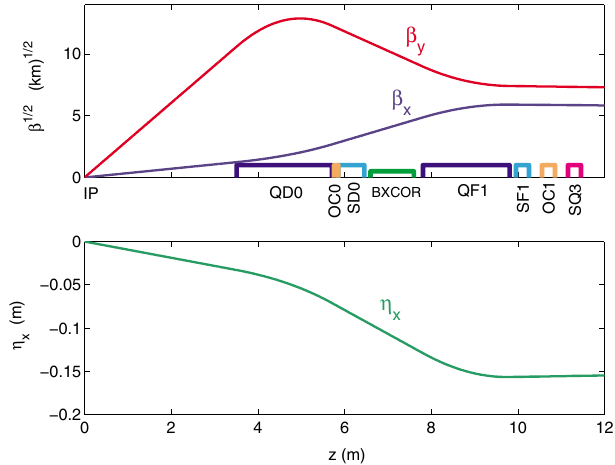
FIG. 2. (Color) Optics of the Next Linear Collider beam delivery system near the IP showing betatron functions (top) and hori- zontal dispersion (bottom). Locations of the final doublet mag- nets are shown, including quadrupoles QD0 and QF1, sextupoles SD0 and SF1, octupoles OC0 and OC1, skew quadrupole SQ3, and optional vertical corrector BXCOR. IP is at z (cid:3) 0 m (cid:3) 3 : 51 m , and the half crossing angle is (cid:13) is L (cid:6) 10 mrad . These figures also show the locations of the final